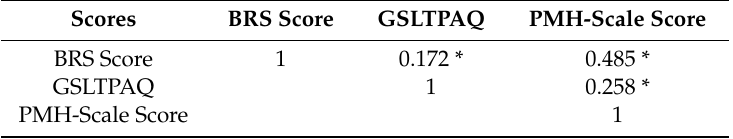
Table 3. Correlations between the physical activities, mental health, and resilience. Scores